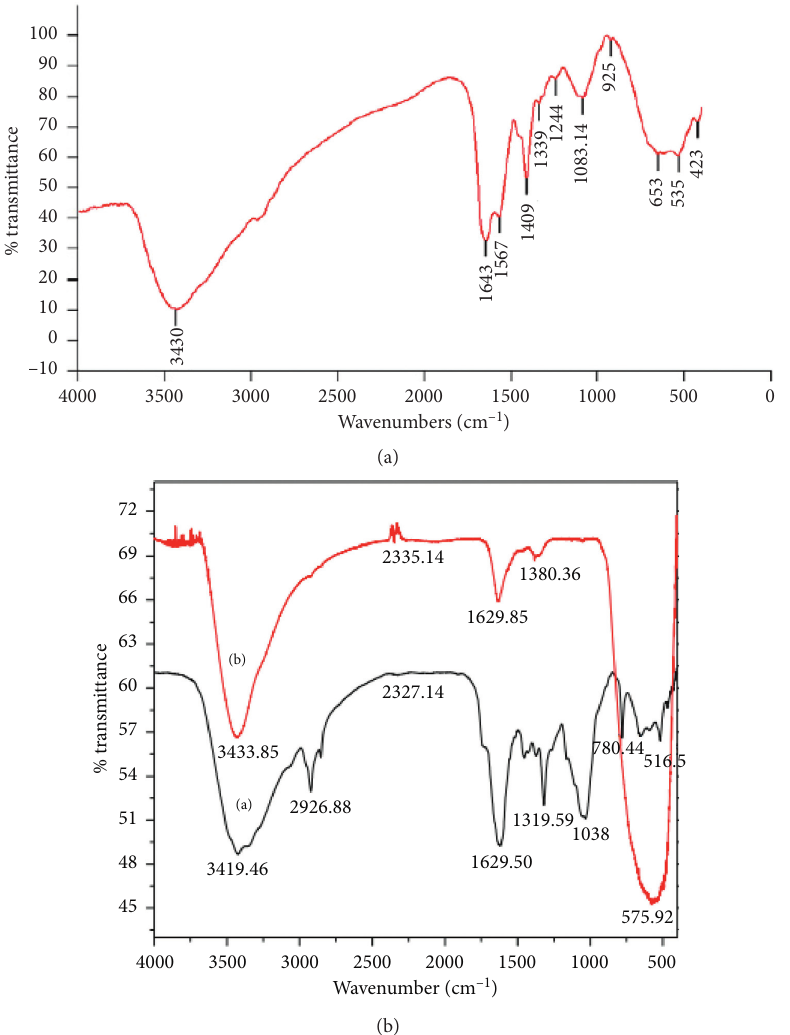
Figure 10: FT-IR spectra of (a) Aeromonas hydrophila- and (b) K. foliosa -assisted (a, FT-IR of extract and b, extract+ TiO TiO 2 NPs [43,